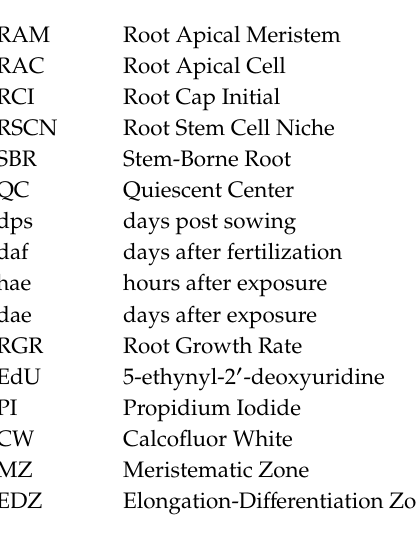
Figure S1. Bright-field images of gametophyte-to-sporophyte transition and embryo development in Ceratopteris richardii ; Figure S2. Graphic representation of di ff erent planes in a hermaphrodite gametophyte; Figure S3. Schematic representation of cell ontogeny in the root body. Table S1. Vascular plant species analyzed to generate Figure 1A; Table S2. Root growth rate for each stem-borne root according to a five-day